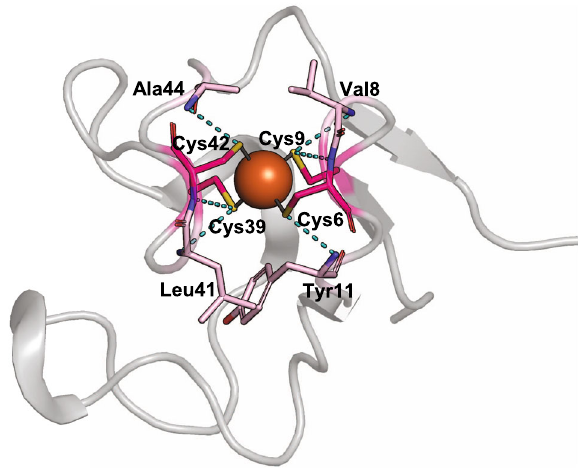
Fig. 1 | Crystal structure of V44A mutant of Cp Rd (PDB ID: 1C09) 24 . The